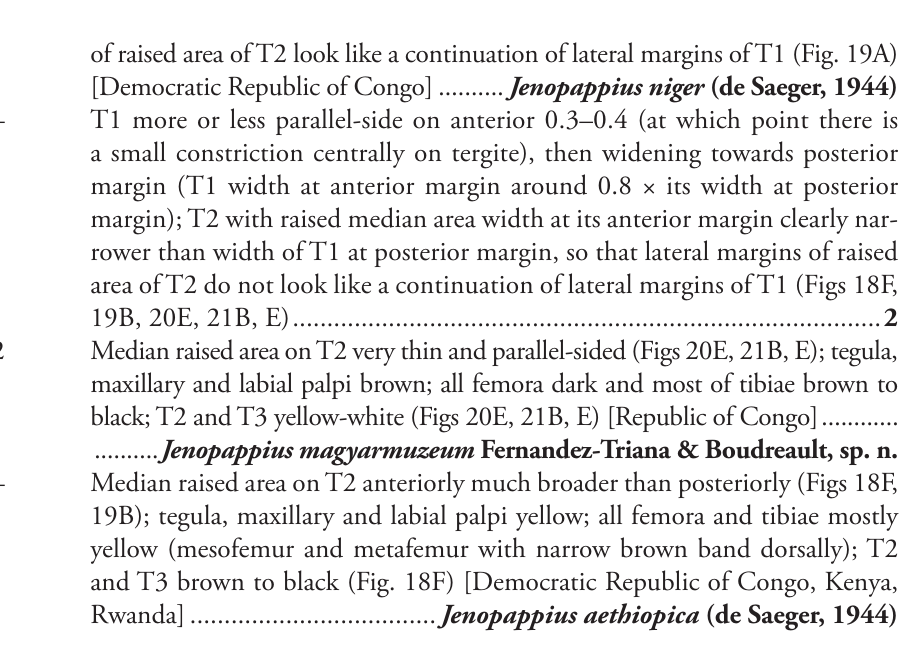
Median raised area on T2 very thin and parallel-sided (Figs 20E, 21B, E); tegula, maxillary and labial palpi brown; all femora dark and most of tibiae brown to black; T2 and T3 yellow-white (Figs 20E, 21B, E) [Republic of Congo] ............ Median raised area on T2 anteriorly much broader than posteriorly (Figs 18F, 19B); tegula, maxillary and labial palpi yellow; all femora and tibiae mostly yellow (mesofemur and metafemur with narrow brown band dorsally); T2 and T3 brown to black (Fig. 18F) [Democratic Republic of Congo,